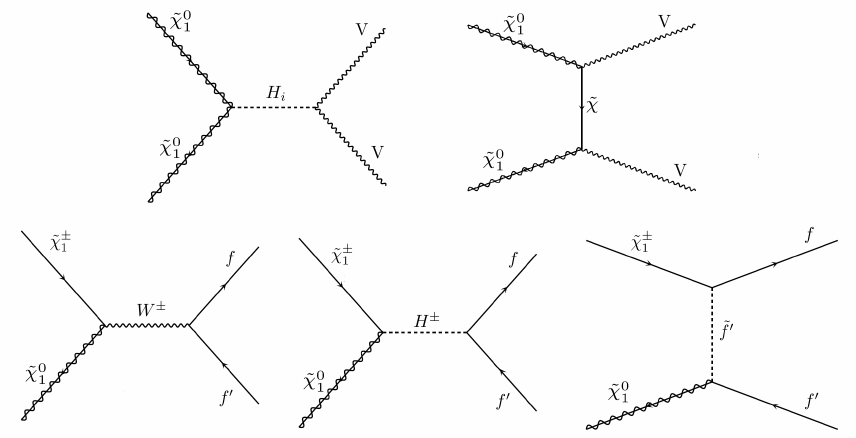
Figure 10 . The Feynman diagrams for the main DM annihilation processes. In the first row, V stands for W boson or Z boson, H stands for the neutral Higgs bosons, ˜ χ stands for the charginos i when V = W and for the neutralinos when V = Z . Besides, the s-channel propagator can also be Z boson when V = W . In the second row, H ± is the charged Higgs bosons, f, f 0 are the SM fermions and ˜ f 0 are their SUSY partners.